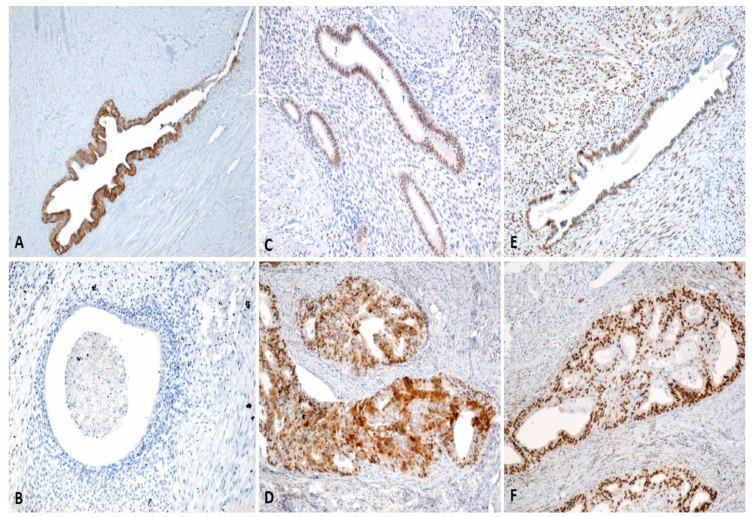
Figure 4. ( A – F )—Labelling of cytokeratins and hormone receptors in endometriosis. ( A ) Myometrial endometriosis—Adenomyosis. The presence of ectopic endometrial tissue and periglandular stroma in the structure of the myometrium is observed. Immunostaining with anti-CK7 antibody (brown label), [ × 100]; ( B ) endometriosis of the abdominal wall. The endometrial glandular epithelium and periglandular stroma are observed among the striated muscle fibers of the rectus abdominus muscle. Negative immunostaining with anti-CK20 antibody, [ × 200]; ( C ) endometriosis of the abdominal wall: endometrial epithelium, periglandular stroma, and ER (brown marking) in the structure of the right abdominal muscle. Immunostaining with anti-ER α antibody, [ × 200]; ( D ) hyperplastic transformed adenomyosis, with atypical cellularity. Endometrial epithelium, periglandular stroma, and intensely positive ER α (brown marking) are visualized in the peritoneal structure, immunostaining with anti-ER α antibody, [ × 200]; ( E ) adenomyosis. In the structure of the myometrium is observed the presence of endometrial epithelium, periglandular stroma, and PR (brown marking). Immunostaining with anti-PR α antibody, [ × 200]; ( F ) area of hyperplastic transformed adenomyosis—endometrial epithelium, periglandular stroma, and PR (brown marking) is observed in the structure of ectopic endometrial epithelium. CK: Cytokeratin, ER α : alpha estrogen receptor, PR: Progesterone